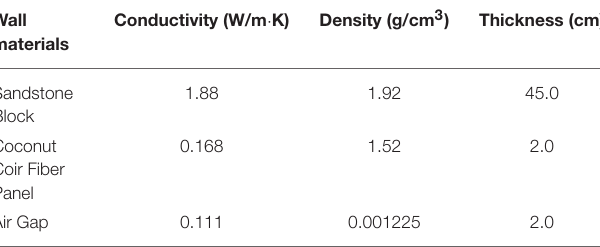
TABLE 4 | Characteristics of materials used for EnergyPlus